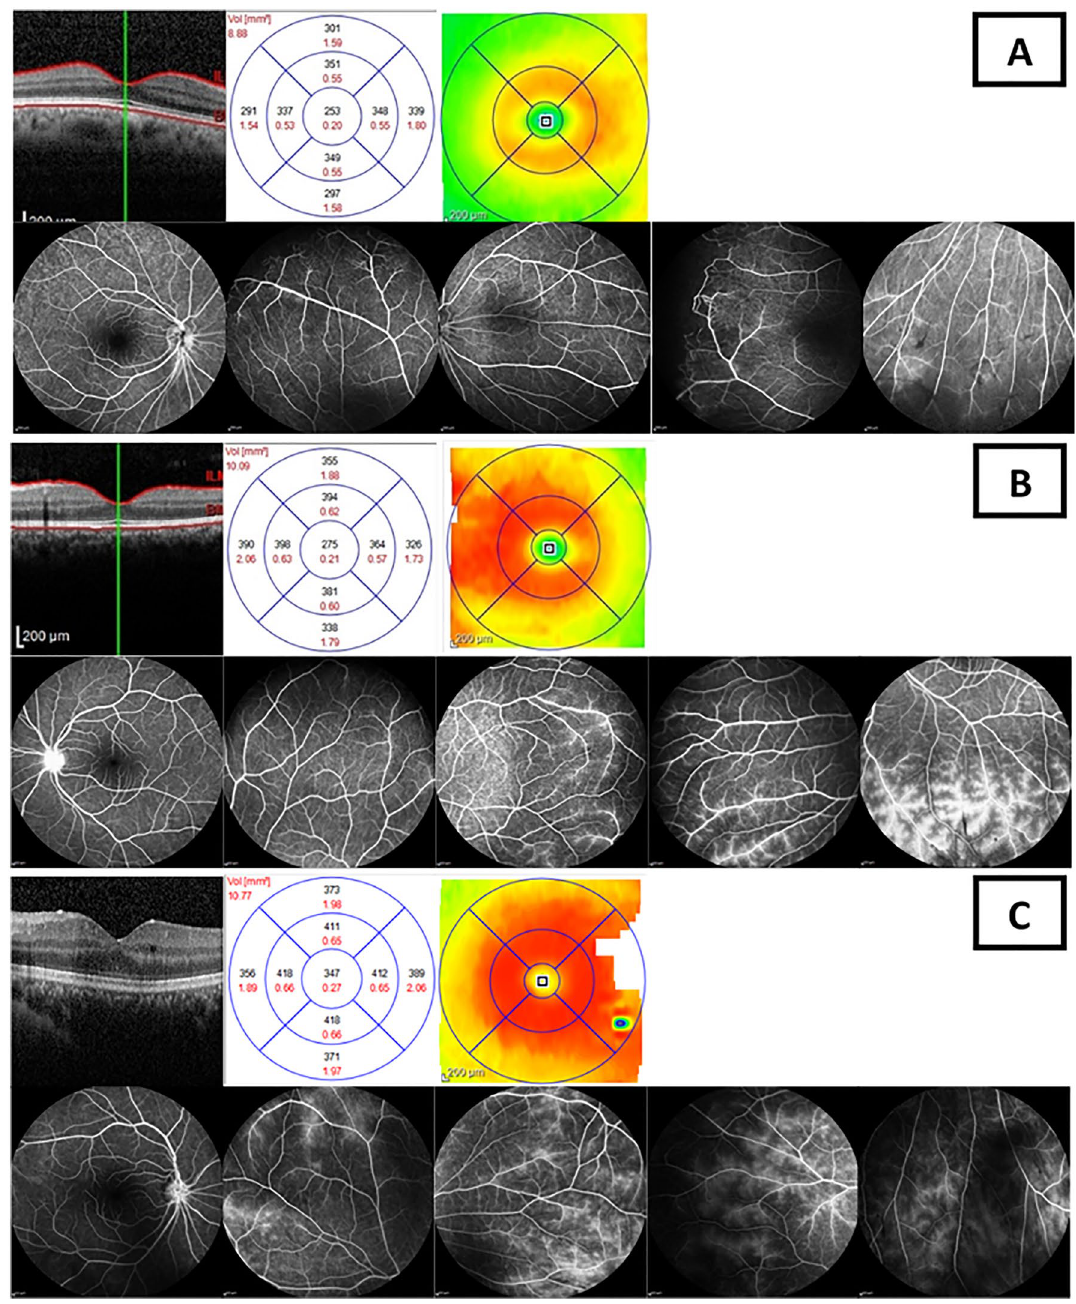
Figure 3. Concomitant OCT and fluorescein angiography (FA) images of three patients with various levels of inflammation to demonstrate the correlation between macular thickness and angiographic score. ( A ) The prototype of concomitant OCT and FA with mild severity of leakage; top row illustrate the OCT images: from left to the right macular B scan centered at the fovea, average thickness and retinal thickness color map (CMT = 259 μm, Mean 3 mm perifoveal thickness = 348.5 μm, mean 6 mm perifoveal thickness = 309 μm, total macular volume = 8.94 mm 3 and central macular volume = 0.20 mm 3 ). The lower row shows FA images from posterior pole and peripheral retina demonstrating optic disc, macular and posterior leakage scores of 0 and total peripheral leakage score of 4. ( B ) The prototype of concomitant OCT and FA with moderate severity of leakage; the top row illustrates the OCT findings: from left to the right macular B scan centered at the fovea, average thickness and retinal thickness color map (CMT = 275 μm, Mean 3 mm perifoveal thickness = 384.25 μm, mean 6 mm perifoveal thickness = 352.25, total macular volume = 10.09 mm 3 and central macular volume = 0.21 mm 3 ). The lower row shows FA images from posterior pole and peripheral retina demonstrating optic disc and posterior leakage score of 2, macular leakage score of 0, and total peripheral leakage score of 8. ( C ) The prototype of concomitant OCT and FA with high grade severity of leakage; the top row illustrates the OCT findings: from left to the right macular B scan centered at the fovea, average thickness and retinal thickness color map (CMT = 347 μm, Mean 3 mm perifoveal thickness = 414.75 μm, mean 6 mm perifoveal thickness = 372.25 μm, total macular volume = 10.77 mm 3 and central macular volume = 0.27 mm 3 ). The second row shows FA images from posterior pole and peripheral retina demonstrating optic disc and posterior leakage scores of 0, macular leakage score of 2 and total peripheral leakage score of